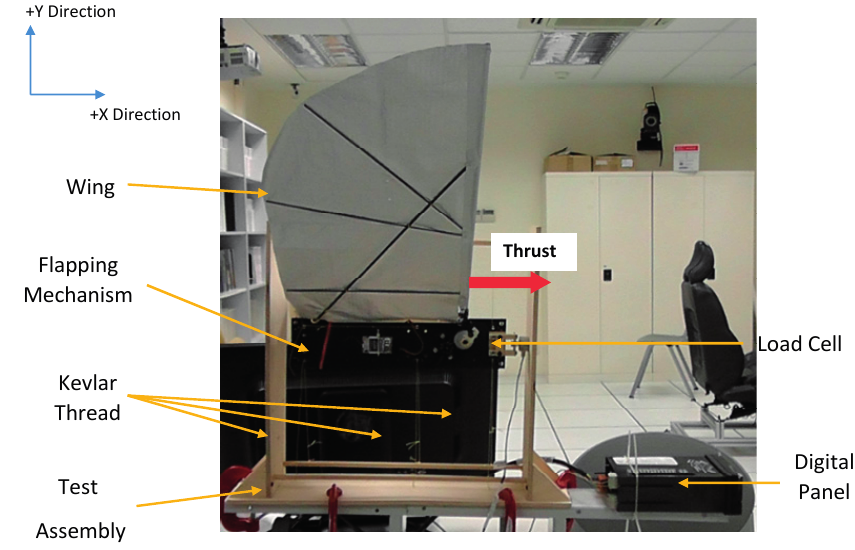
Figure 30. Side view of the load cell thrust measurement setup.